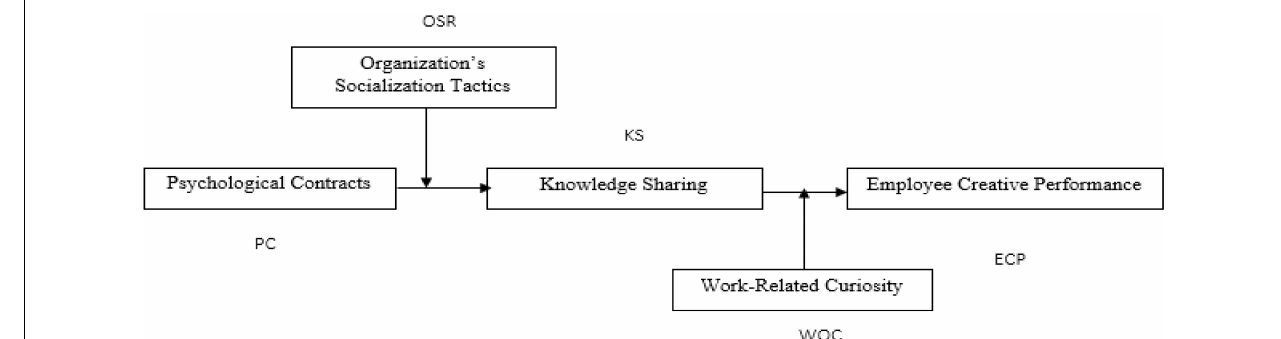
FIGURE 1 | Theoretical